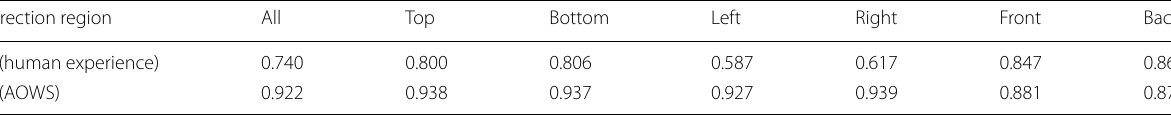
Table 5 Thrust drivability of object manipulation mission Direction region All Top Bottom Left Right Front Back D (human experience) 0.740 0.800 D